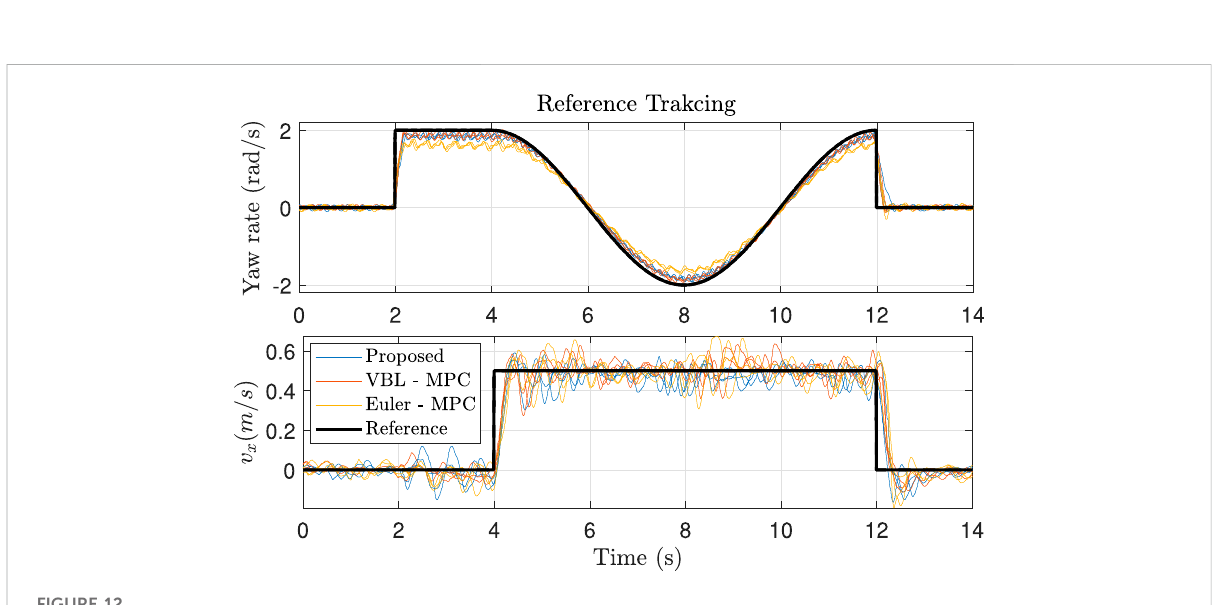
FIGURE 12 Reference tracking for quadrupedal robot trotting. Each controller is tested three times. The responses are too noisy; thus, the results are smoothed using the moving average fi